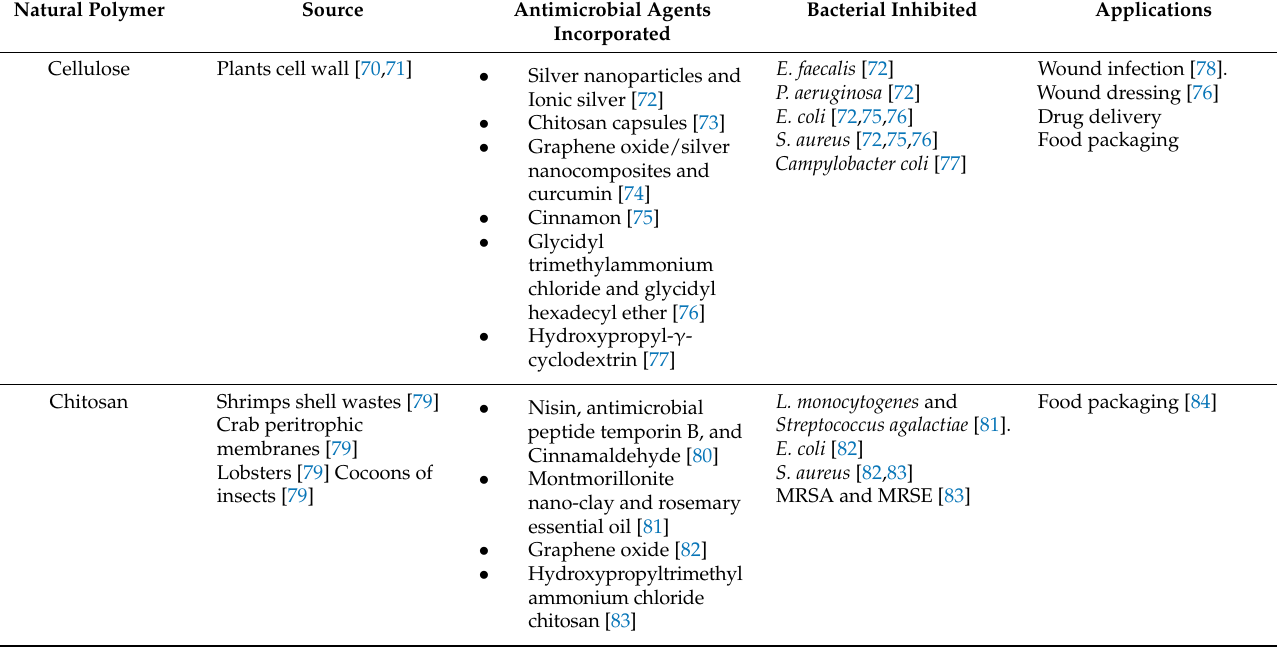
Table 1. Summary of natural polymers used to inhibit bacteria